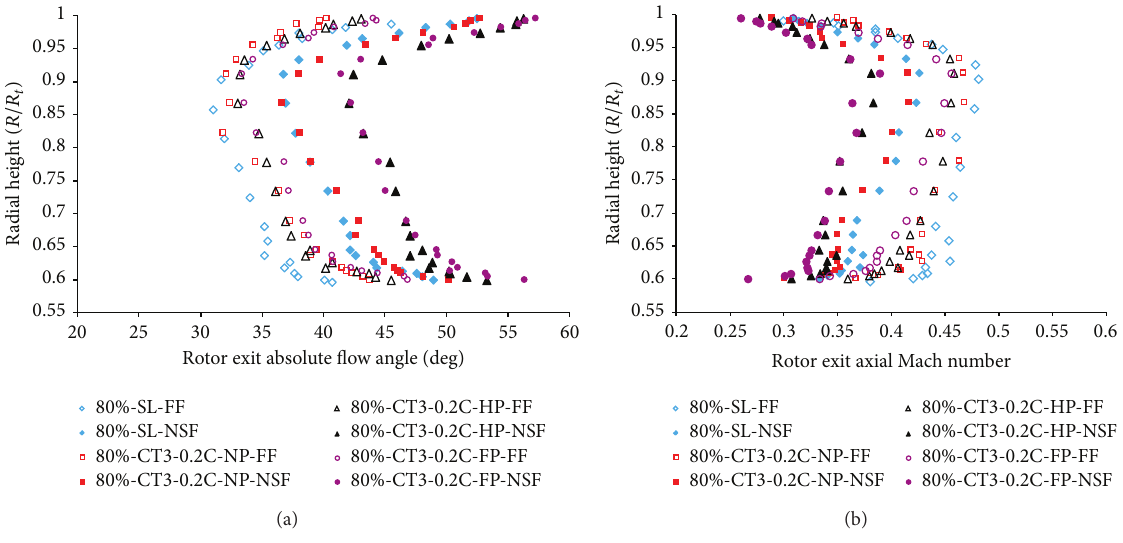
Figure10:Comparativevariationsof(a)rotorexitabsoluteflowangleand(b)axialMachnumberforthesolidcasingandthreeconfigurations of casing treatment and plenum chamber at full flow (FF) and near stall flow (NSF)